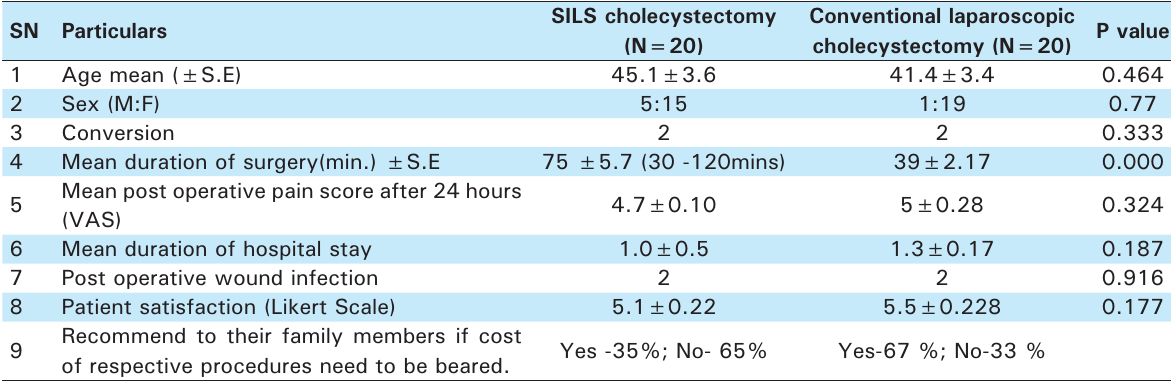
Table 1. Comparison between single incision laparoscopic cholecystectomy (SILC) and conventional laparoscopic